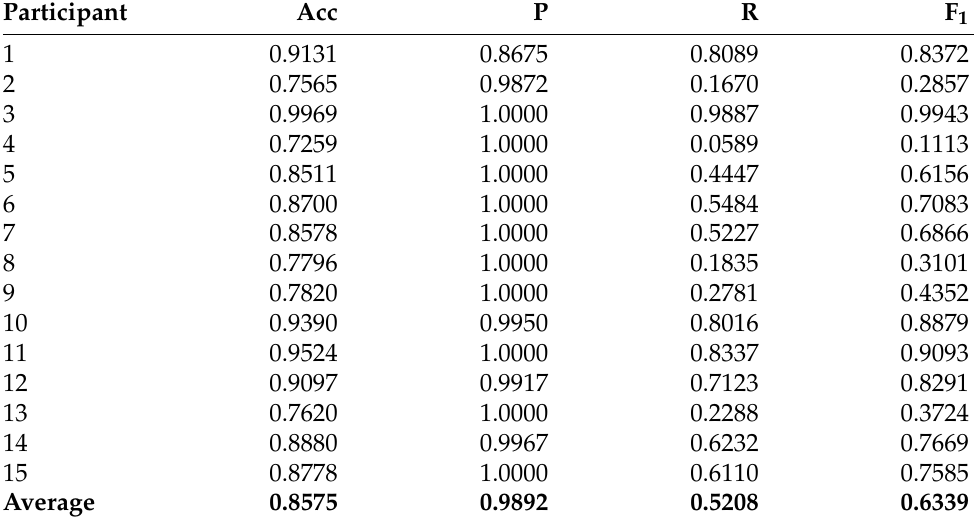
Table 6. Federated Learning